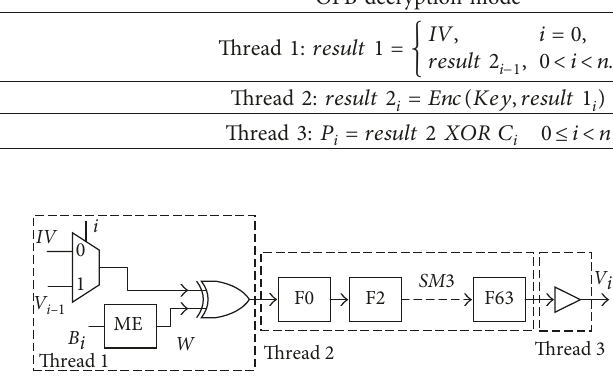
Figure 4: SM3 3-thread algorithm